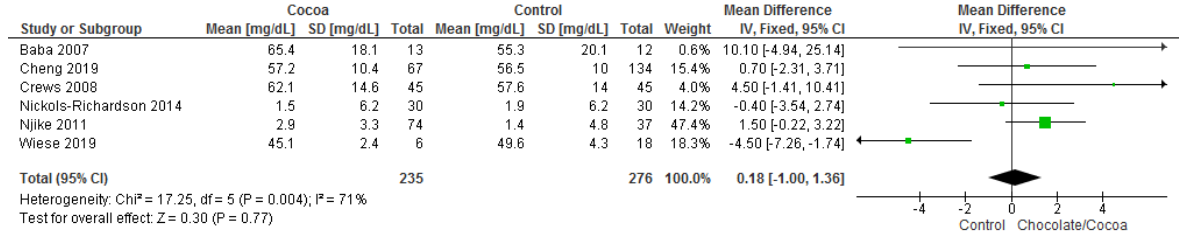
Figure 8. Forest plot of comparison: chocolate versus control, with the outcome-high density lipoprotein (mg/dL). Nichols- Richardson (2014) and Nijike (2011) reported mean changes and their respective SD, instead of mean scores.